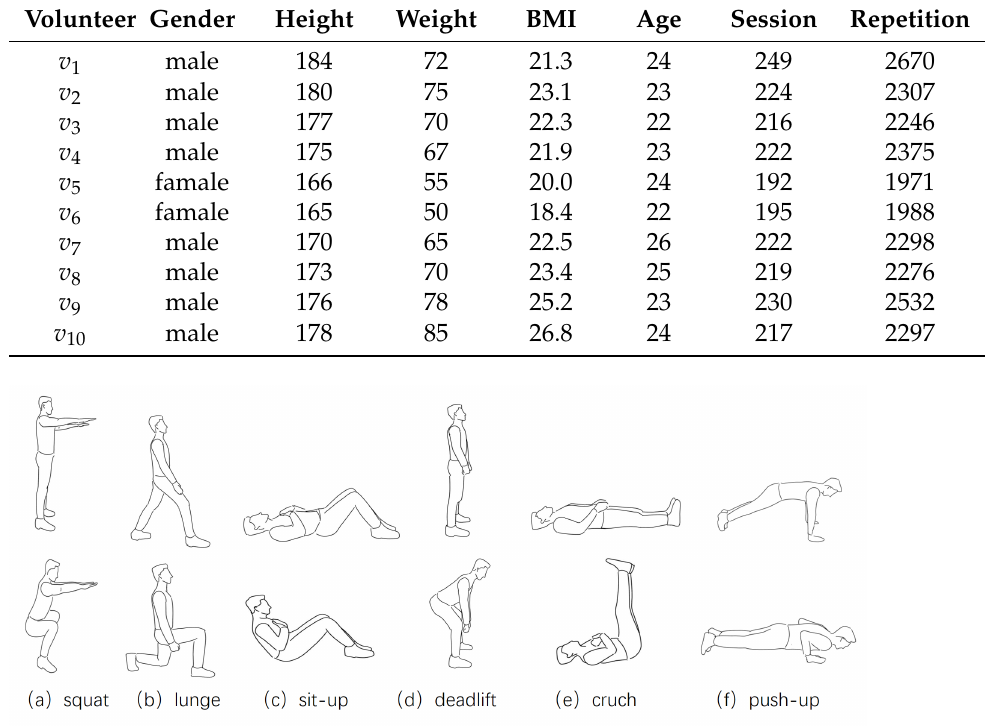
Figure 15. Six kinds of freehand exercises